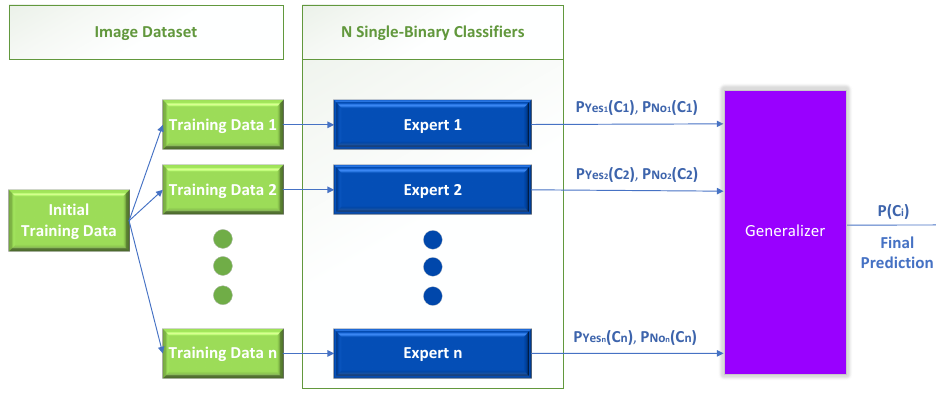
Figure 5. Meta-Learning, binary classifiers